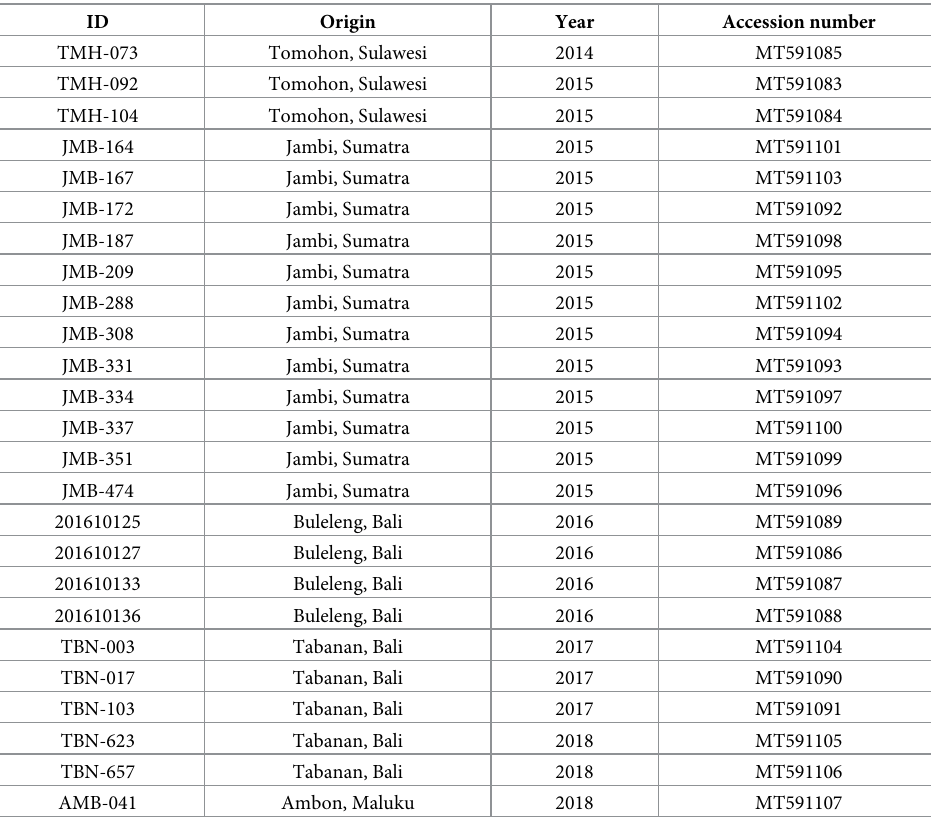
Table 1. Overview of newly sequenced CHIKV strains included in phylogenetic analysis.